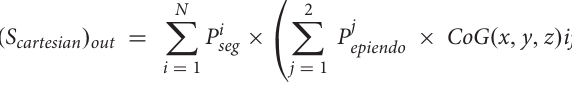
Frontiers in Physiology |